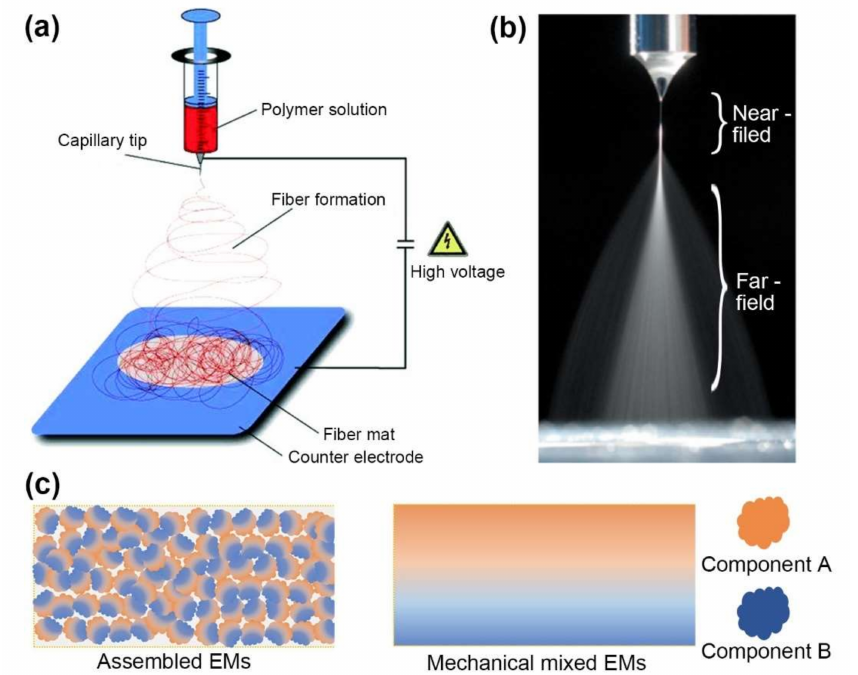
Figure 1. ( a ) Schematic of electrospinning setup. Reprinted with permission from Ref. [23]. Copyright 2007 Copyright John Wiley and Sons. ( b ) Illustration of electrospray process consist- ing of the Tylor cone, emitted jet and broken-up droplets. Adapted with permission from Ref. [24]. Copyright 2018 Copyright Elsevier. ( c ) Schematic comparison of homogenous dispersed composite EMs (components A and B) assembled by EHDA and heterogeneous dispersed EMs prepared by mechanical